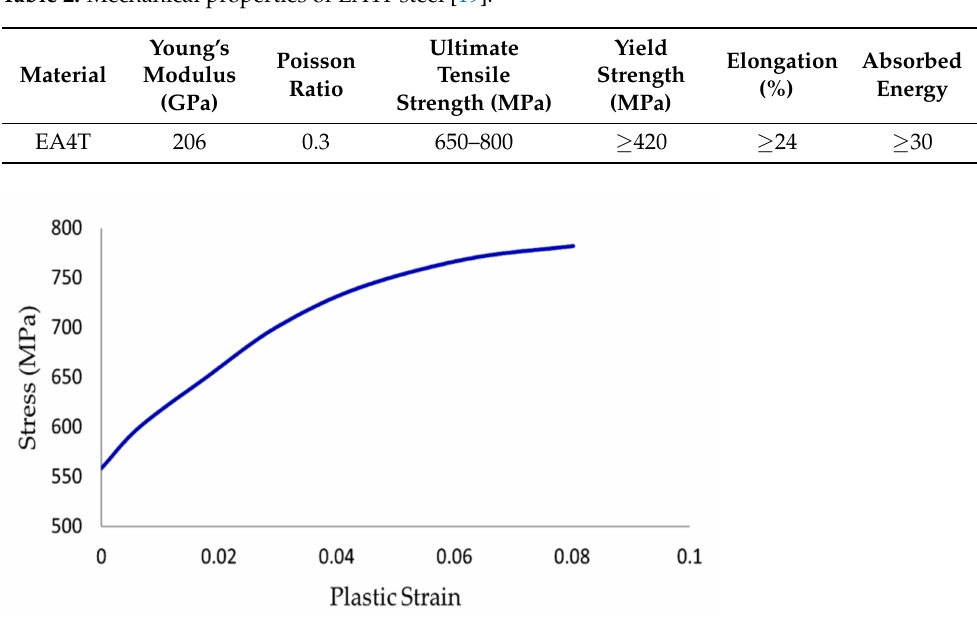
Table 2. Mechanical properties of EA4T steel [19].